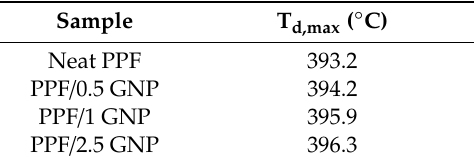
Figure 3. ( a ) TGA thermograms; ( b ) dTG curves of PPF/GNP nanocomposites with different weight fractions of GNPs recorded with the heating rate of 10 °C/min under a nitrogen atmosphere. Table 1. TGA results of all studied samples.